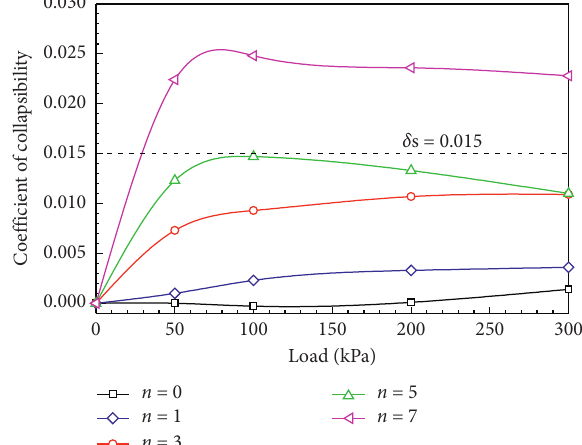
Figure 4: Coefficient of collapsibility of compacted loess specimens as a function of load at different wetting-drying-freezing-thawing